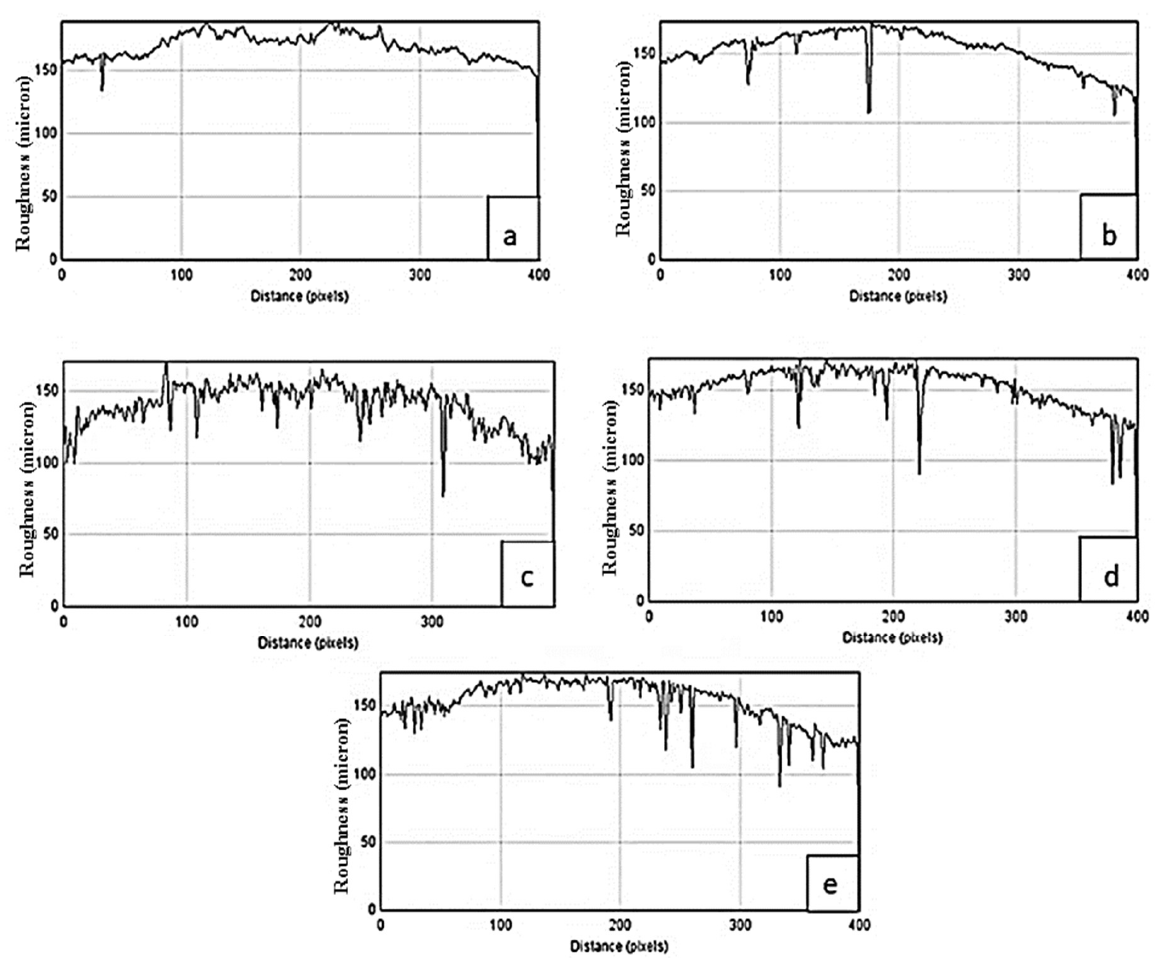
Figure 3. Surface roughness of pure AlSb at different deposition times ( a ) 1 h, ( b ) 1.5 h, ( c ) 2 h, ( d ) 2.5 h, and ( e ) 3 h. Table 3. Surface roughness of pure and Mg-doped AlSb thin films at different deposition times. Roughness (Microns) at Deposition Time Distance Sr. No. (Pixels)